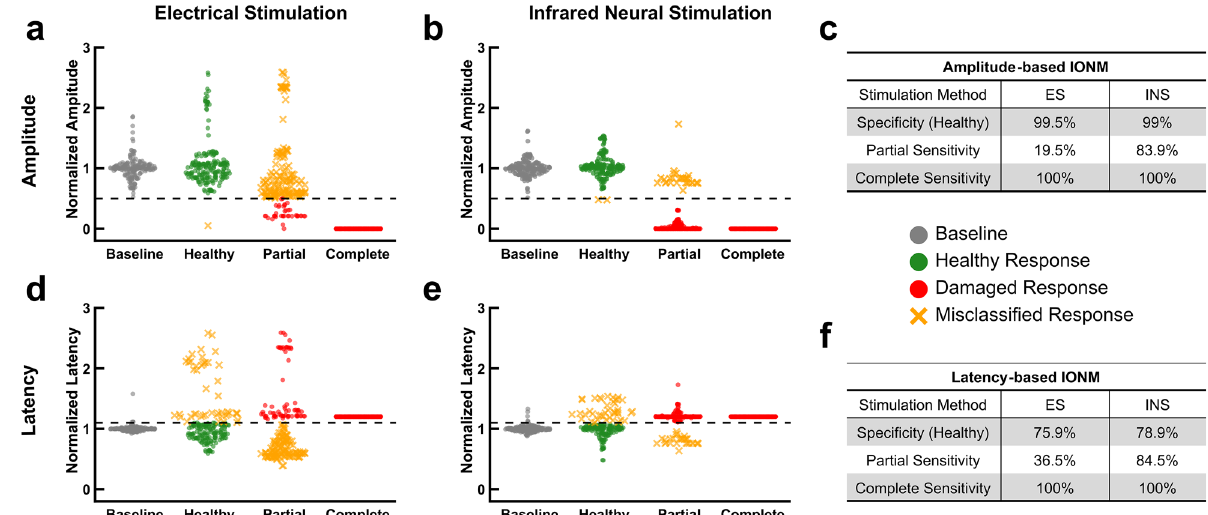
Figure 1. Infrared neural stimulation is more sensitive to partial nerve transections. ( a) Normalized CMAP amplitudes resulting from ES in baseline, healthy, partial transection, and complete transection conditions. Black dashed line represents the amplitude damage threshold (50% decrease). ( b ) Normalized CMAP amplitudes resulting from INS in baseline, healthy, partial transection, and complete transection conditions. ( c ) The sensitivity and specificity for the amplitude-based IONM approach to transection injuries. ( d ) Normalized CMAP latencies resulting from ES in baseline, healthy, partial transection, and complete transection conditions. Black dashed line represents the latency damage threshold (10% increase). If no CMAP was evoked latency was set to 1.2 for ease of visual interpretation. ( e ) Normalized CMAP latencies resulting from INS in baseline, healthy, partial transection, and complete transection conditions. ( f ) Sensitivity and specificity for the latency- based IONM approach to transection injuries. Specificity in all cases was calculated using the ‘Healthy’ category of responses. All data is normalized to the mean baseline values for each individual nerve. n = 10 nerves for all data sets (5